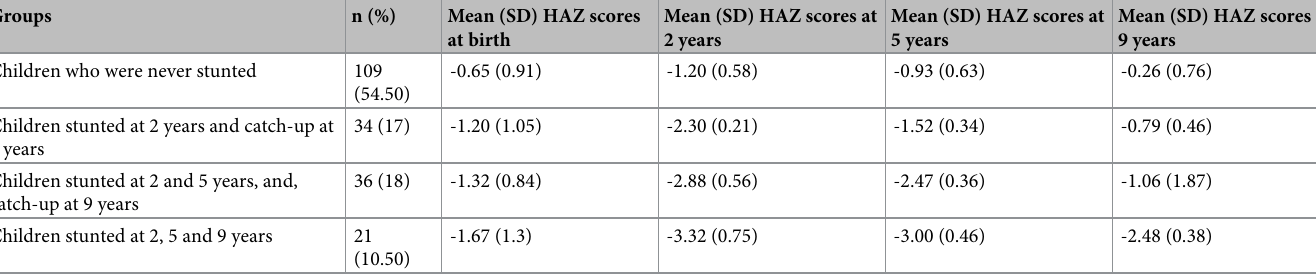
Table 2. Grouping of children in MAL-ED cohort based on stunting � status at 2, 5 and 9 years (n = 200 # ). Groups